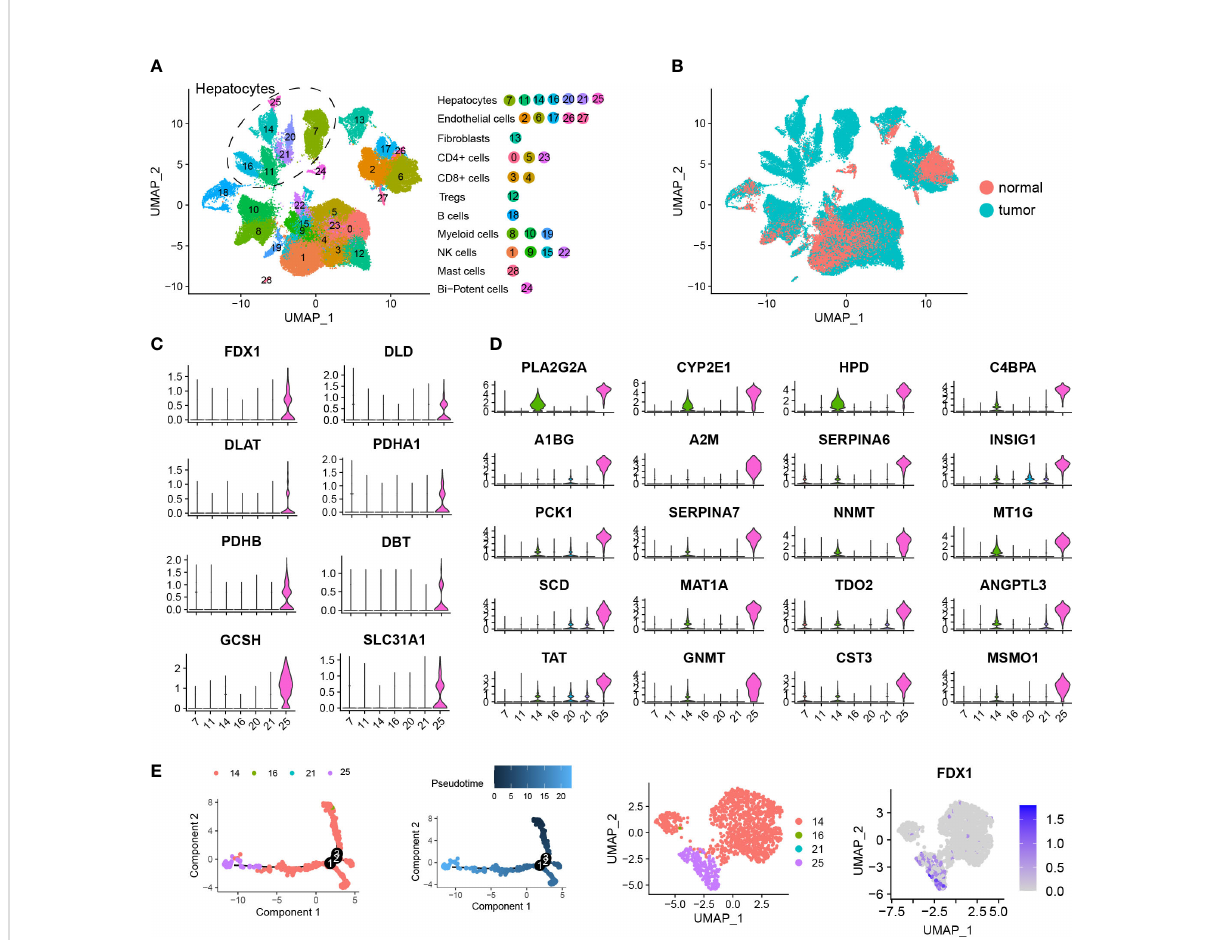
FIGURE 3 Single cell analysis identifying cuproptosis-related hepatocytes. (A) UMAP visualization showing the hepatocellular carcinoma landscape of 73,589 cells containing 29 clusters across 28 HCC samples using dotplot. Each dot represents a single cell and hepatocyte subgroups are encircled with dotted lines. (B) UMAP visualization showing the distribution of the single cell HCC landscape between tumor and normal tissues. (C) Violin plots showing expression levels of 8 cuproptosis-related genes among 7 hepatocyte clusters, including FDX1, DLD, DLAT, PDHA1, PDHB, DBT, GCSH and SLC31A1. (D) Violin plots showing expression levels of the top 20 marker genes in cuproptosis-related hepatocytes. (E) Pseudotime analysis showing the predicted evolution of hepatocytes. UMAP visualization showing the distribution of hepatocytes and gene expression of